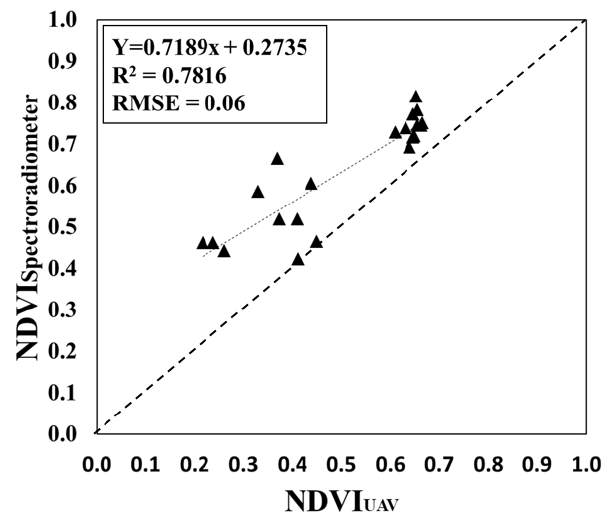
Figure 16. Comparison of NDVI using the UAV and spectroradiometer.